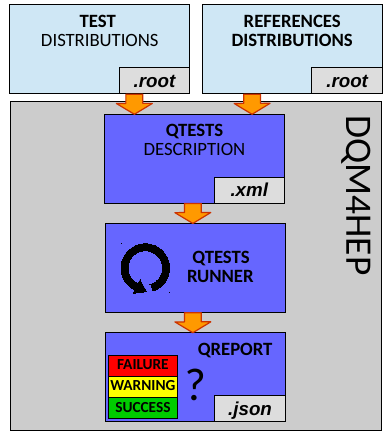
Figure 1. O ffl ine quality test processing workflow: from monitor elements and ref- erences to quality test